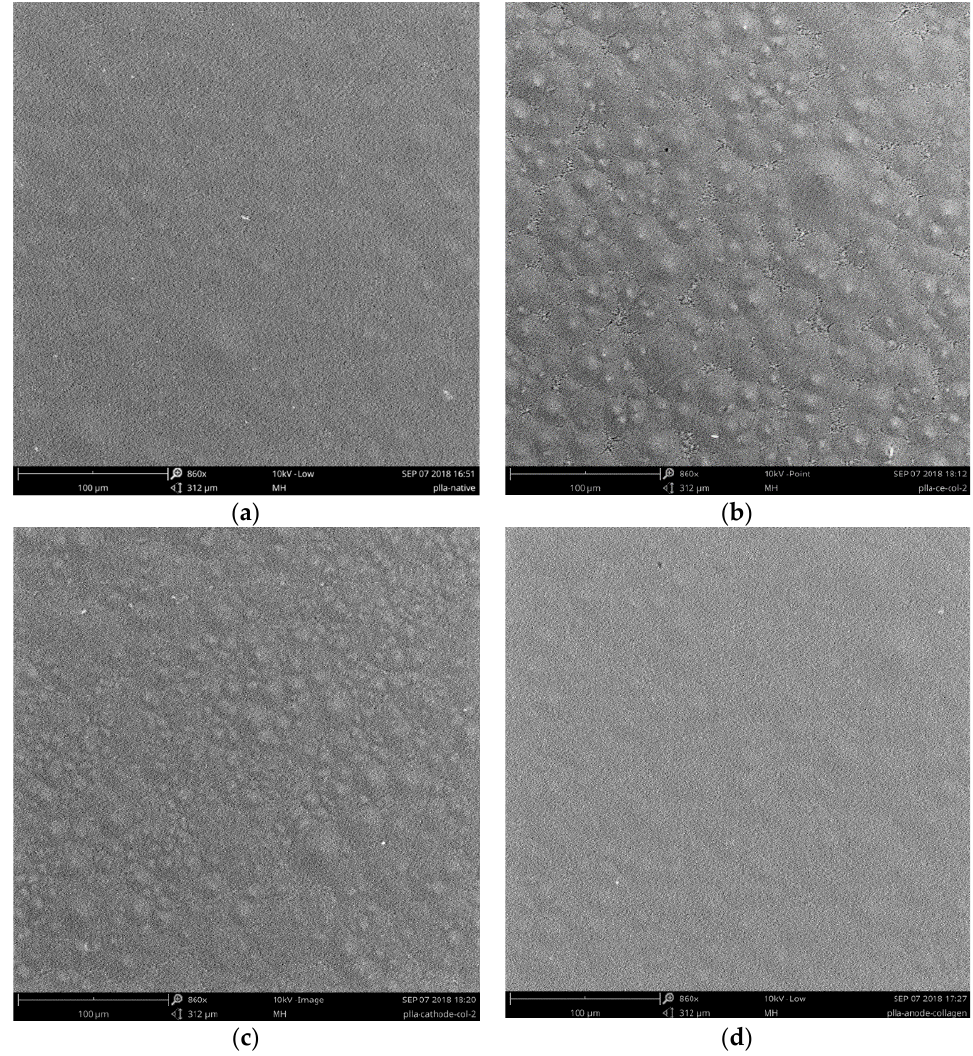
Figure 4. SEM micrographs of ( a ) the initial PLA films and the collagen ‐ coated PLA films: ( b ) PLA ‐ S ‐ col, ( c ) PLA ‐ C ‐ col, ( d ) PLA ‐ A ‐ col. Scale bar is 100 μ m. col, ( c ) PLA-C-col, ( d ) PLA-A-col. Scale bar is 100 µ